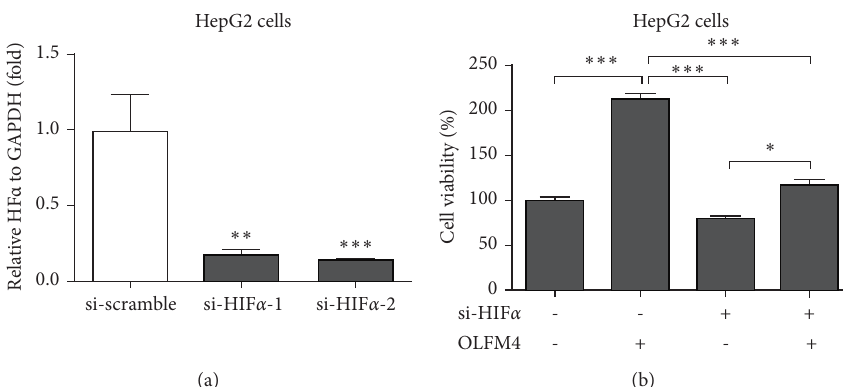
Figure 6: HIF1 α is involved in the regulation of OLFM4 in liver cancer proliferation. (a) siRNAs against HIF1 α successfully inhibited the mRNA expression of HIF1 α in HepG2 cells measured by qRT-PCR assay ( ∗∗ P < 0 . 01, ∗∗∗ P < 0 . 001); (b) the knockdown of HIF1 α alleviated the increase of OLFM4 plasmid on liver cancer proliferation in HepG2